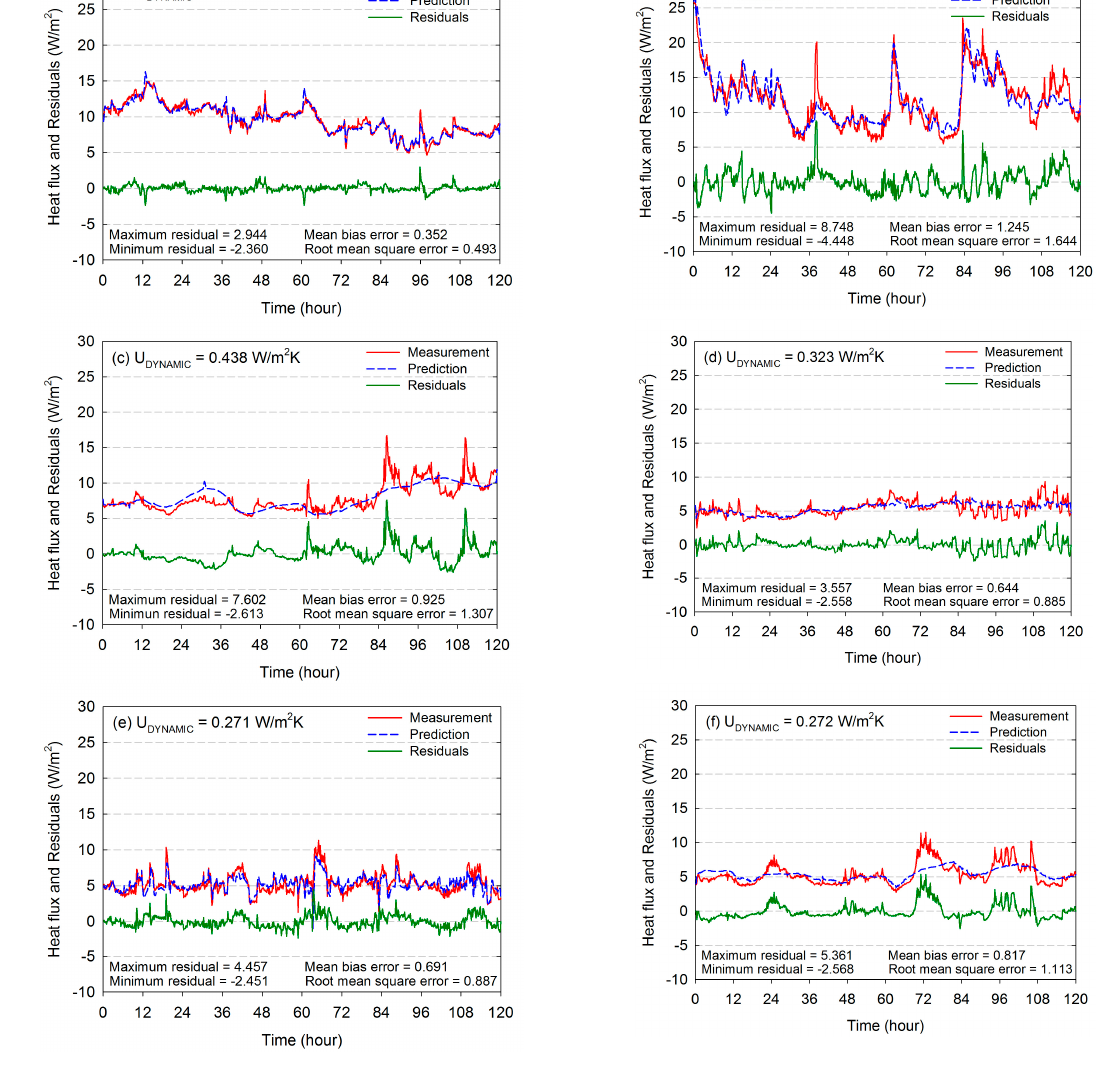
Figure 6. Comparison between measured and predicted heat fluxes: ( a ) Case 1; ( b ) Case 2; ( c ) Case 3; ( d ) Case 4; ( e ) Case 5; ( f ) Case 6.